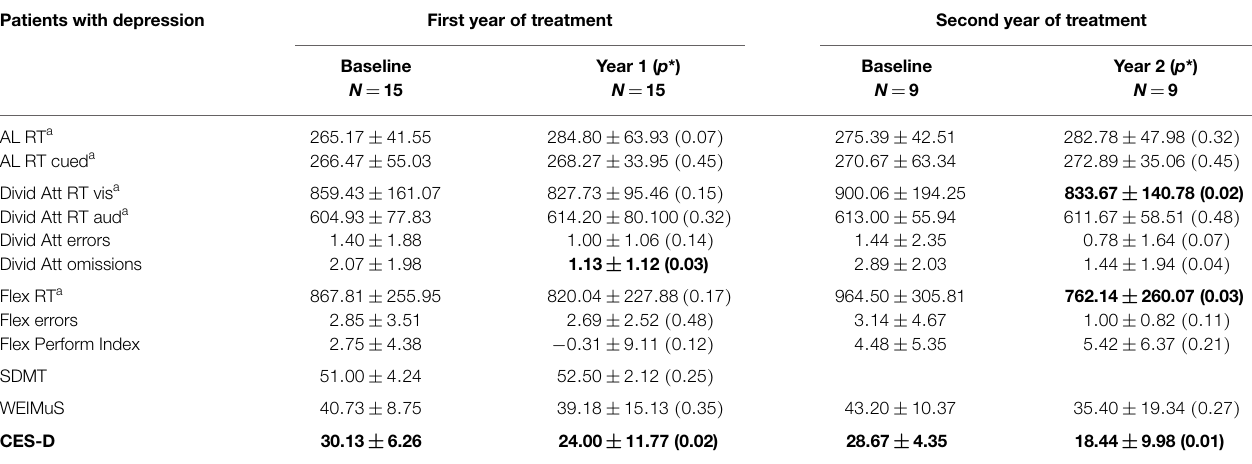
TABLE 5 | Analysis of cognitive parameters from patients with depression at baseline . Patients with